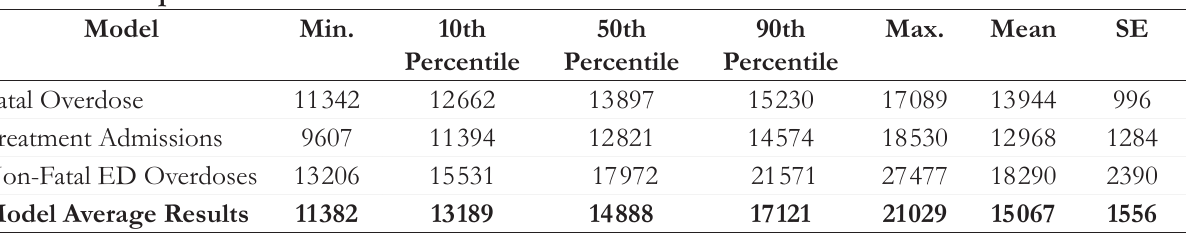
Table 3. Multiplier Model